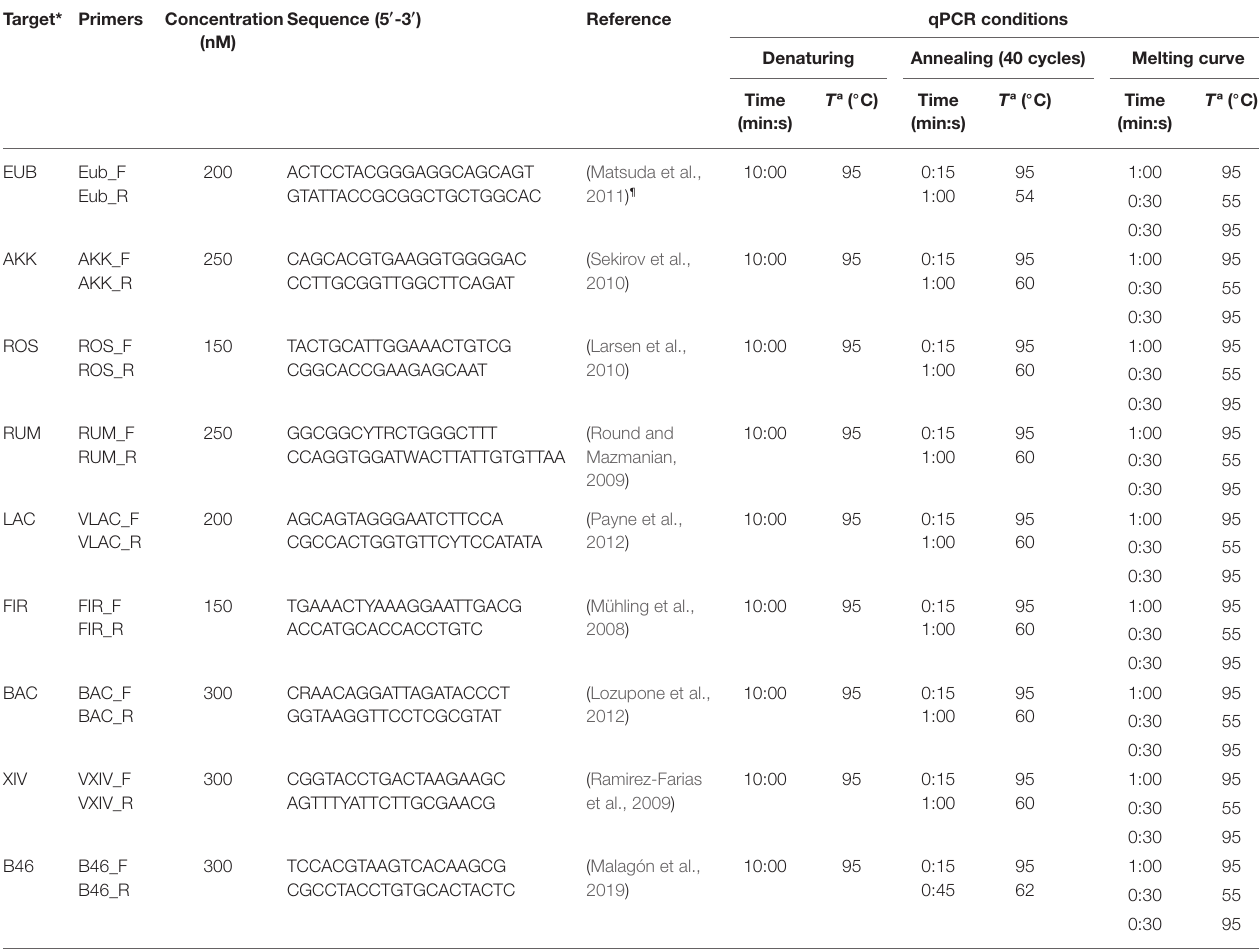
TABLE 2 | 16S rRNA-targeted primers sequences, concentrations, and qPCR conditions used in this work for SYBR green chemistry. Target* Primers Concentration